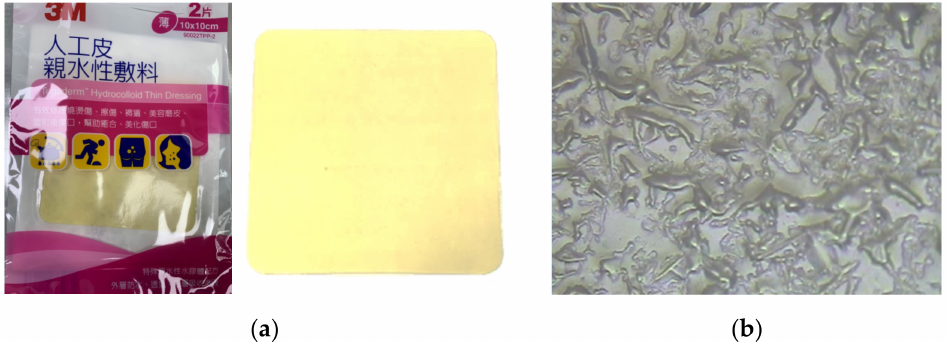
Figure 1. ( a ) Optical photographs and ( b ) surface morphology of hydrocolloid thin wound dressing.